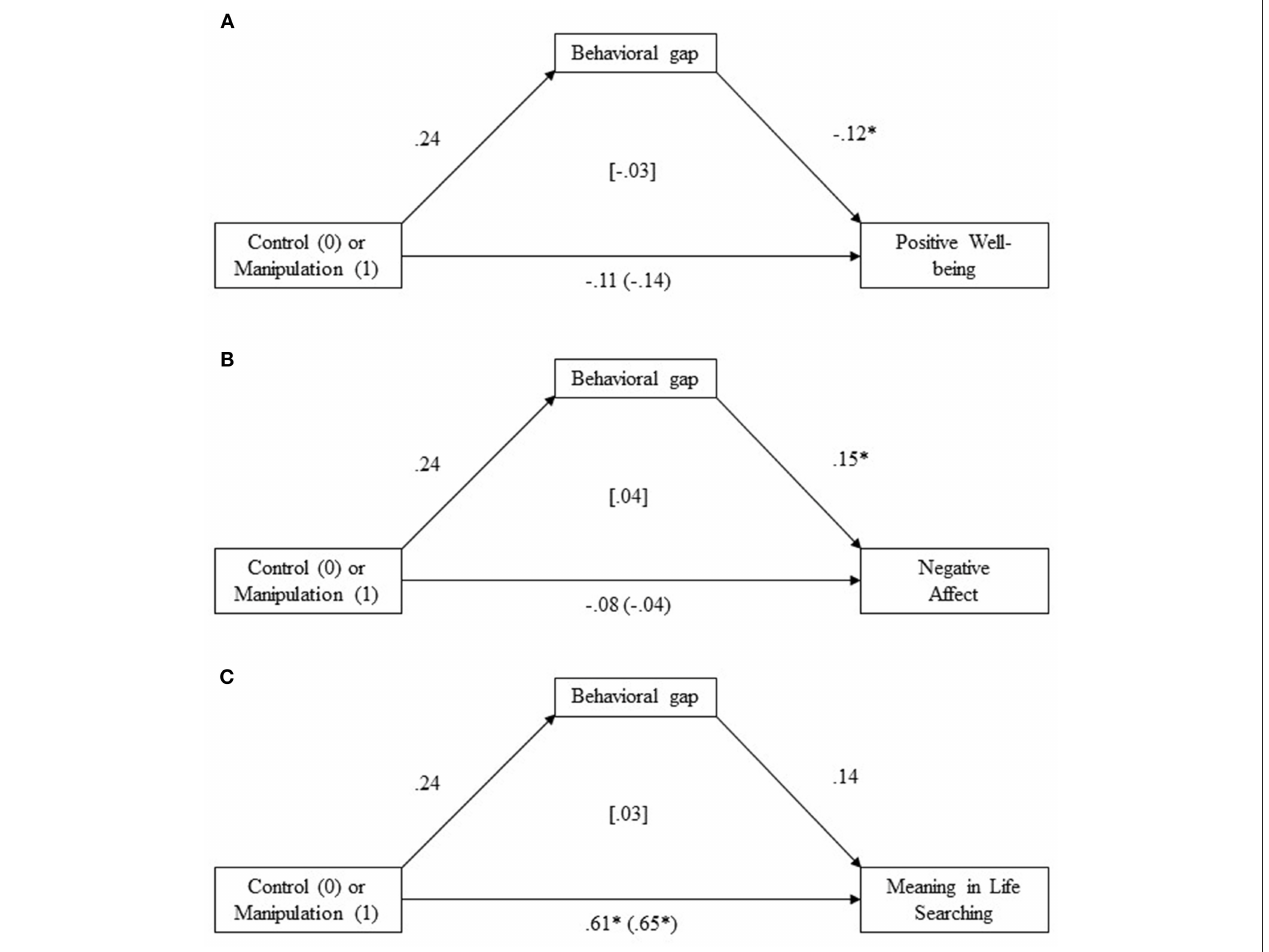
FIGURE 3 | Unstandardized regression coefficients for the relationships between the presence of a manipulation, perceived behavioral gap, and (A) Positive Well-being, (B) Negative Affect, and (C) Meaning in Life Searching. The indirect effect is presented in square brackets; the total effect is presented in round brackets. * p <